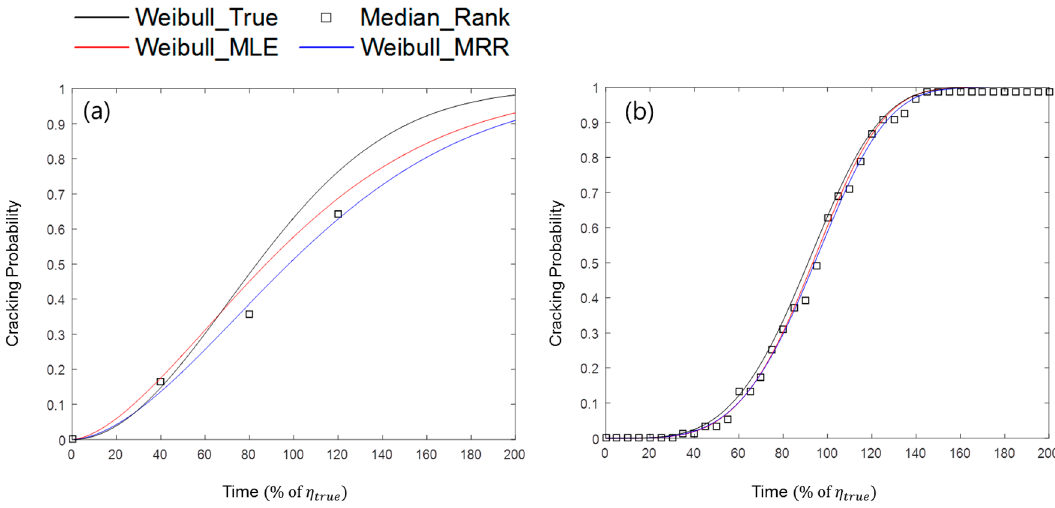
Figure 4. Two examples of simulation experiments with relatively ( a ) poor test condition; and ( b ) ideal test condition.